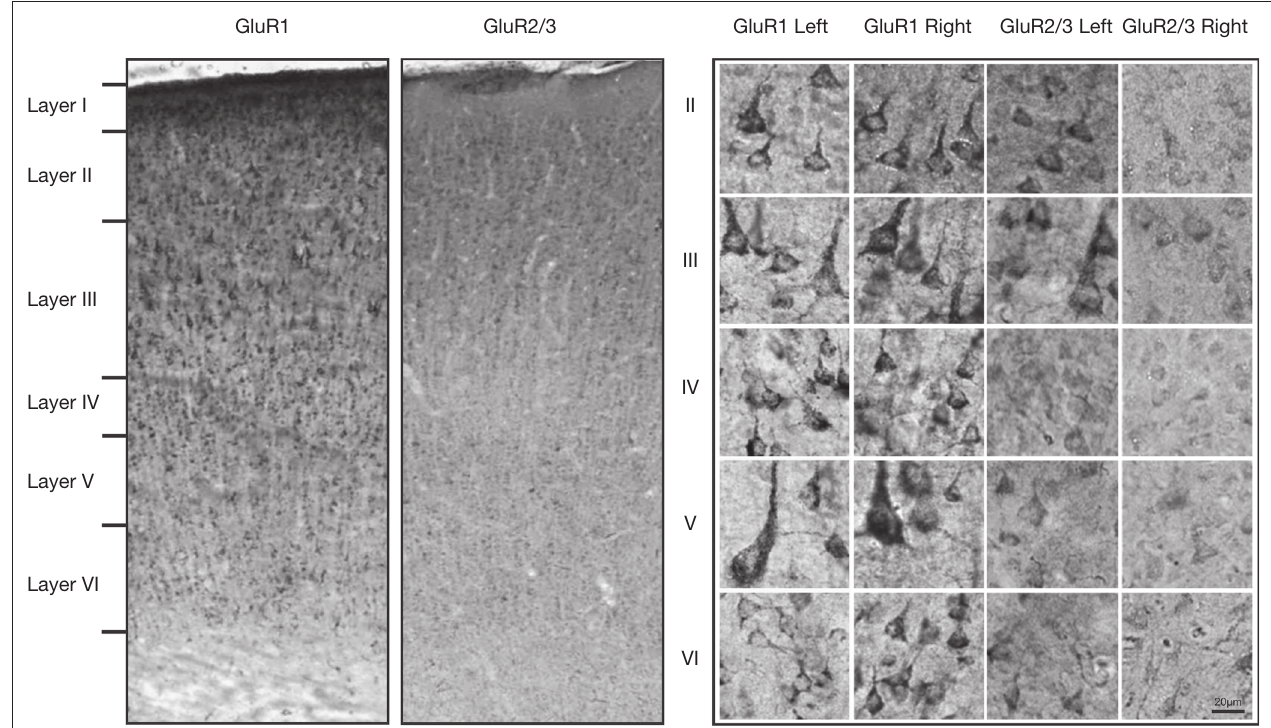
FIGURE 1 | Left: Photomicrographs of GluR1 and GluR2/3 immunostaining in coronal sections through area 3b of a control hemisphere. The laminar pattern of GluR1 and GluR2/3 receptor subunit surface expression maps onto